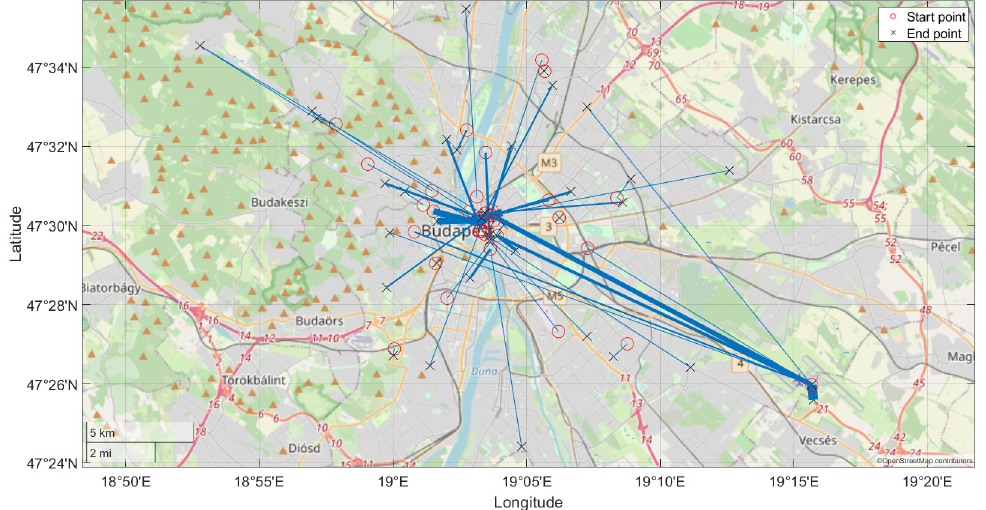
Fig 5. The cluster centroids are represented as lines on the map of Budapest. The start and end points of a recommended public transport line are marked by yellow circles and black crosses, respectively. The width of the line is proportional to the size (and hence, importance) of the cluster. The narrower lines represent smaller, while the wider lines represent bigger clusters.